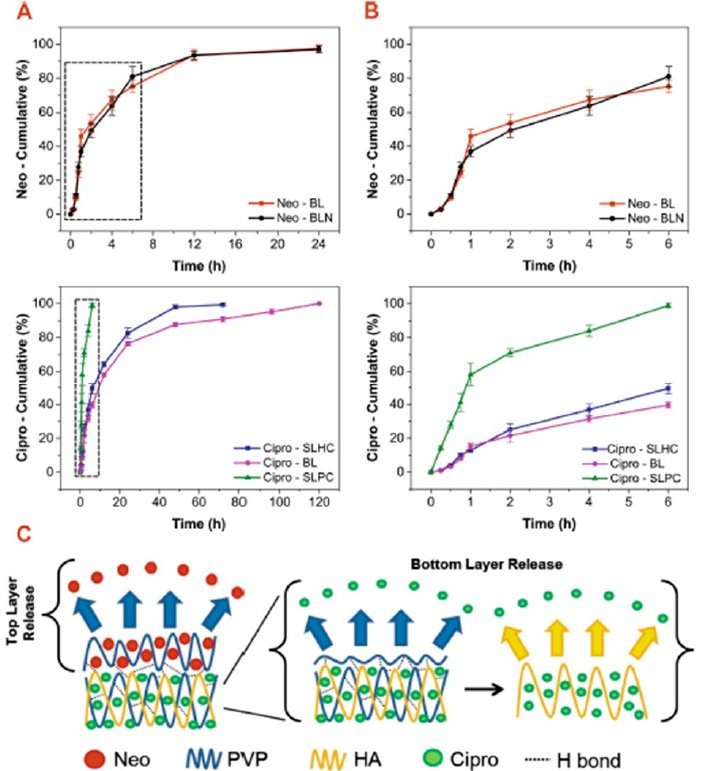
Figure 11. ( A ) Release profiles of eosin (top panels) and ciprofloxacin (bottom panels) over a period of 24 and 120 h, respectively. ( B ) Release results of eosin (top panels) and ciprofloxacin (bottom panels) for the first 6 h. ( C ) Schematic representation of the hypothetical drug release mechanism from the bilayer construct placed on a moist medium such as a wound. Potential establishment of hydrogen bonds within the top layer and at the interface between the top and bottom layers are shown as dashed lines. Neo: eosin based antiseptic. BL: full bilayer construct, BLN: the bilayer construct with no ciprofloxacin, SLHC: single layer with HA, SLPC: single layer without HA, and SLHP: single layer without ciprofloxacin. From [80].